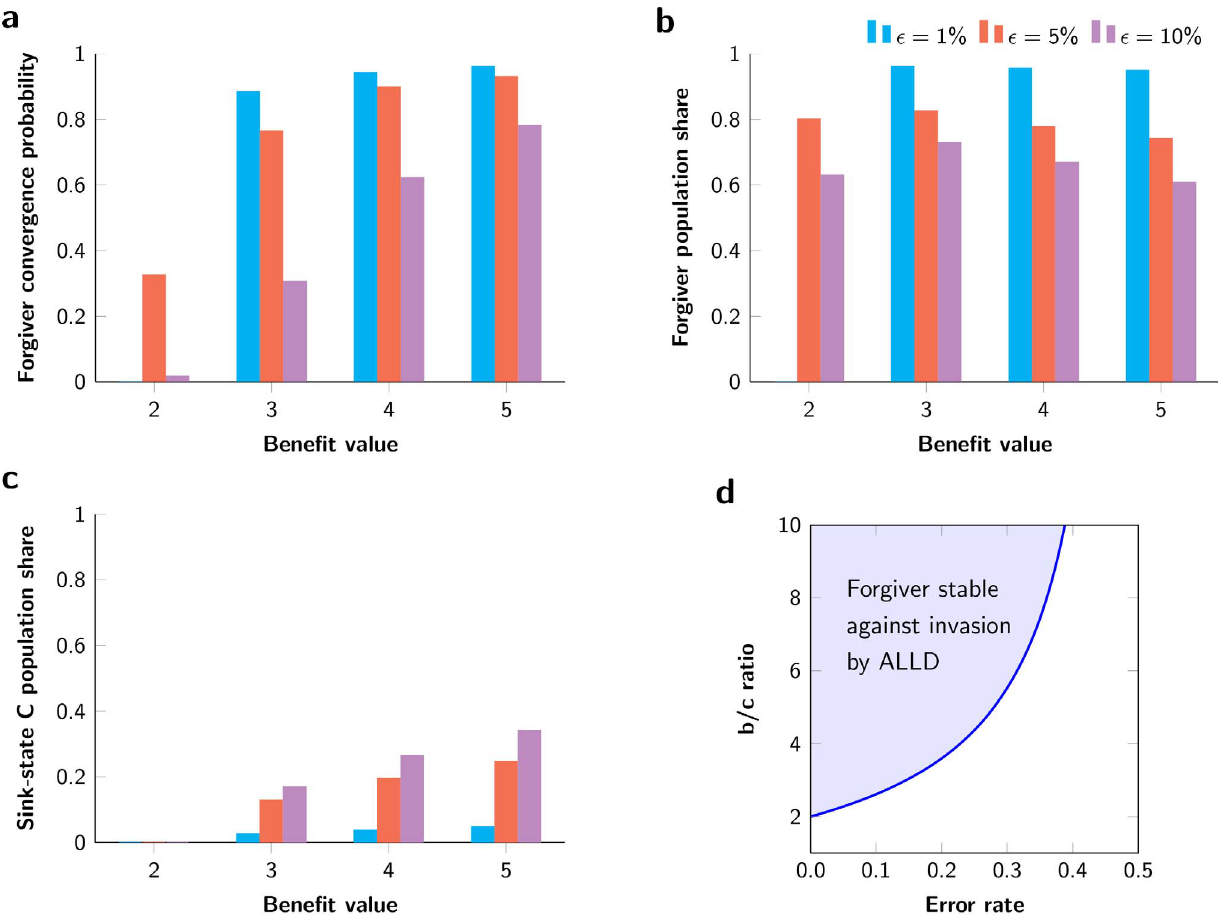
Figure 4. Robustness of results across various benefit values and error rates. a | Convergence probability to the Forgiver equilibrium of a uniform-random point in the 26 -simplex. Note that for higher error rates (increasing noise-level), the probability to converge to the cooperative equilibrium is much lower. b | Population share of Forgiver ( S 14 ) in the Forgiver equilibrium. Observe the relationship between the higher error rates and the lower population share of Forgiver. c | Population share of sink-state C strategies ( S 5 , S 9 , S 13 , S 26 ) in the Forgiver equilibrium. Higher error rates lead to higher proportions of unconditional cooperators. d | In the infinitely repeated game, for all value pairs of b = c and E in the blue shaded area, ALLD cannot invade Forgiver since the average payoff of Forgiver playing against itself is higher than the average payoff of ALLD against Forgiver (see Inequality (1)).